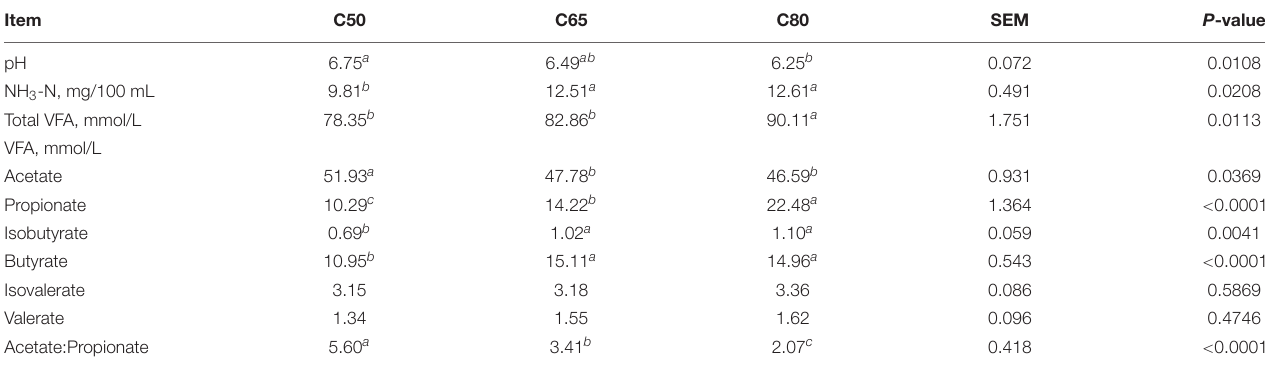
TABLE 1 | Rumen fermentation parameters affected by dietary concentrate-to-forage ratios.